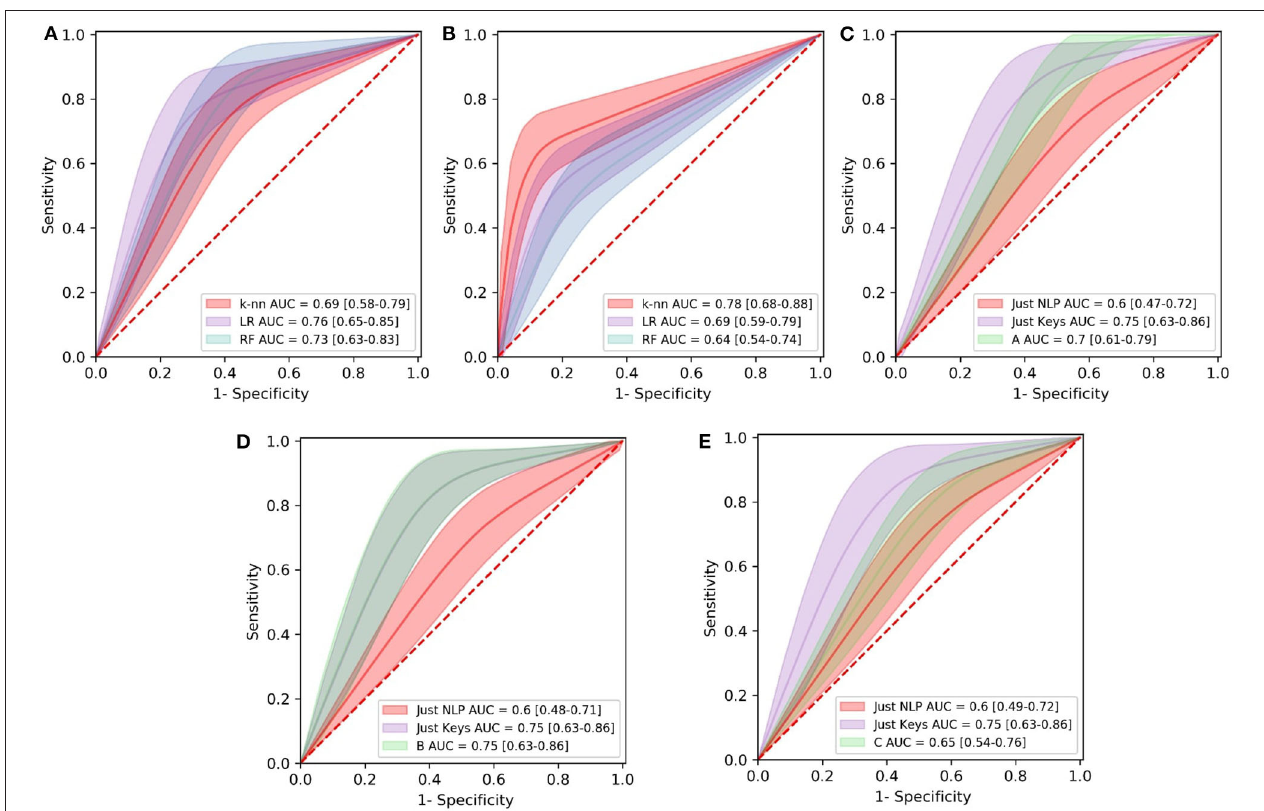
FIGURE 4 | Comparison of Receiver Operating Characteristics (ROC) curves of all the models in the first (A) , second (B) , and third (C–E) experiment. Area Under the Curve (AUC) values for models are shown with 95% Confidence Intervals. LR, Logistic Regression; RF, Random Forest; knn, k-Nearest Neighbors.